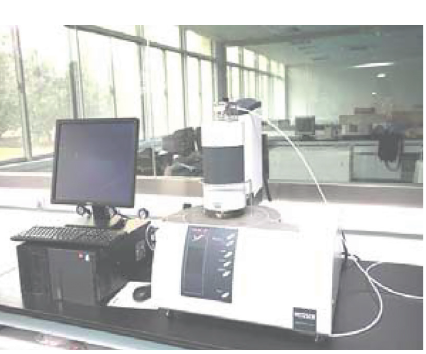
Figure 2: Sample analysis